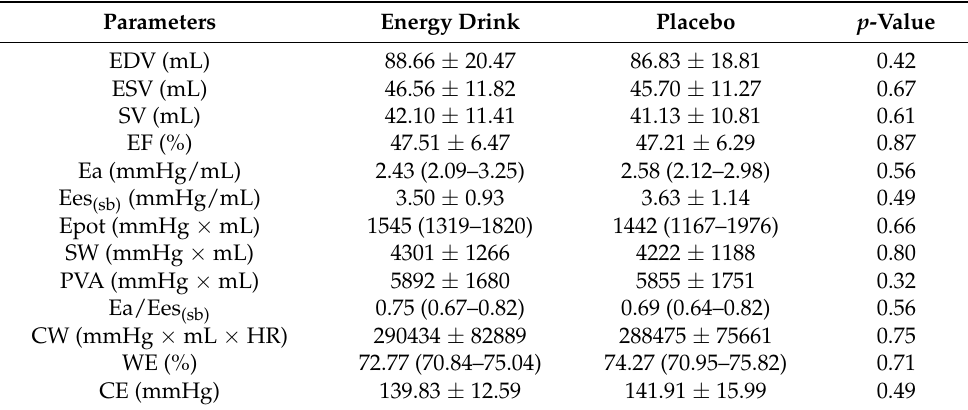
Table 2. Left Ventricular Hemodynamics and Efficiency Parameters at Baseline ( n =